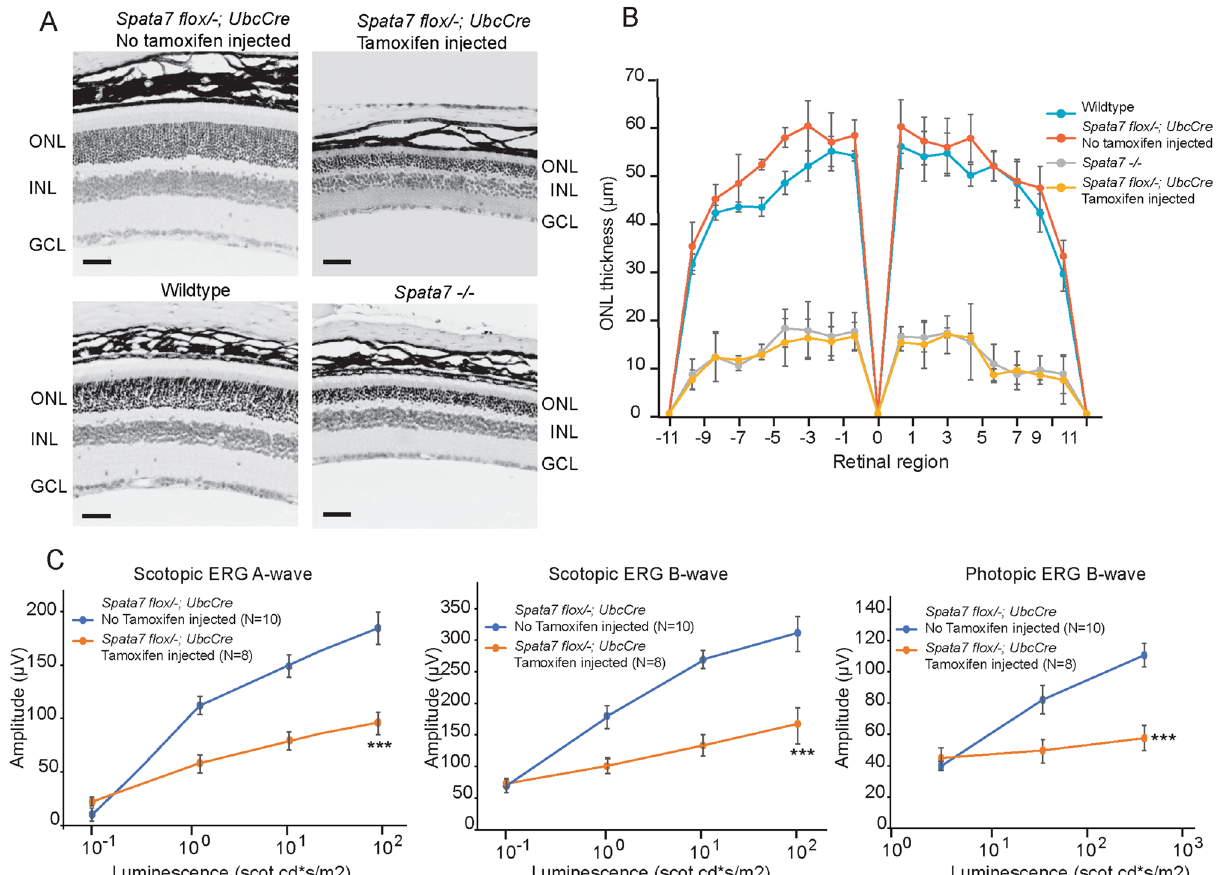
Figure 2. Significant photoreceptor degeneration due to loss of Spata7 in adult mouse retina. ( A ) Hematoxylin and eosin staining of paraffin-embedded retinal sections shows reduced ONL thickness in 6-month-old Spata7 flox/− ; UbcCreERT2 mice following tamoxifen induction at 3 months of age. Tamoxifen non-injected Spata7 flox/− ; UbcCreERT2 mice and 3-month-old wild-type and Spata7 −/− mice act as controls. ONL outer nuclear layer, INL inner nuclear layer, GCL ganglion cell layer. ( B ) Spider plot showing retinal morphometry reveals reduced ONL thickness resulting from loss of Spata7 either in the germline or in adults. The thickness of the ONL was measured at 20 equally spaced positions along the vertical meridian of the retina. Position 0 corresponds to the optic nerve head. Each point represents the mean ± SEM obtained for each group (n ≥ 3 mouse retinas). ( C ) 6-month-old Spata7 flox/− ; UbcCreERT2 mice with tamoxifen induction at 3 months of age exhibit reduced ERG scotopic a-wave and b-wave and photopic b-wave amplitudes compared to non-injected controls. Statistical analysis was performed using the Mann–Whitney test (*** p < 0.001). N = 10 and N = 8 for Spata7 flox/− ; UbcCreERT2 mice without or with tamoxifen induction,